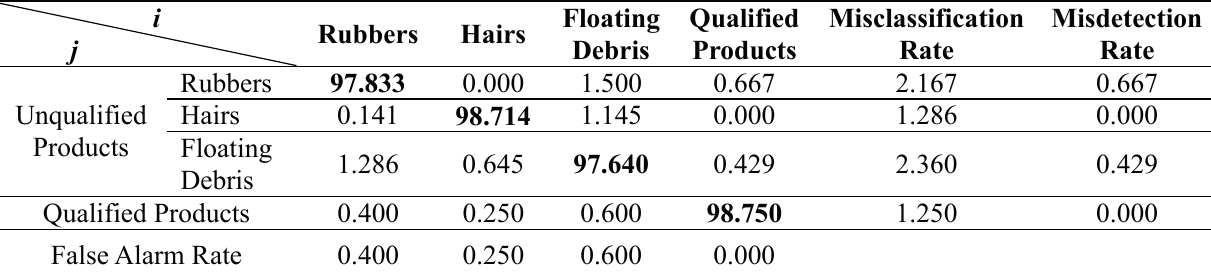
Table 2. Confusion matrix of the detection